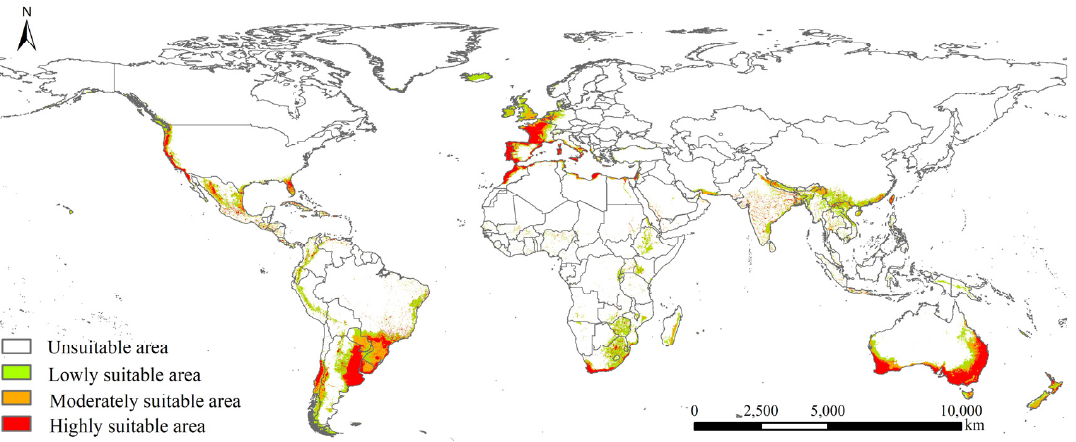
Figure 3. Potential geographical distribution of Phoracantha semipunctata under near current cli- mate.